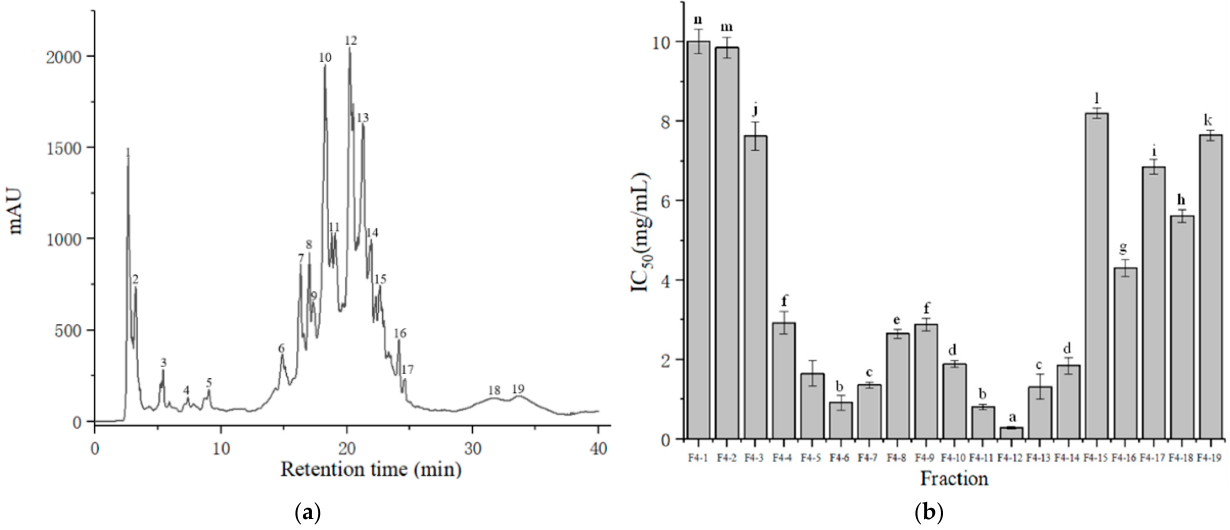
Figure 3. Chromatograph obtained by prep-HPLC of fraction F4 ( a ) and ACE inhibitory activities of fractions F4-1–F4-19 ( b ). The column values of a–n with the different superscript indicated a significant difference ( p <